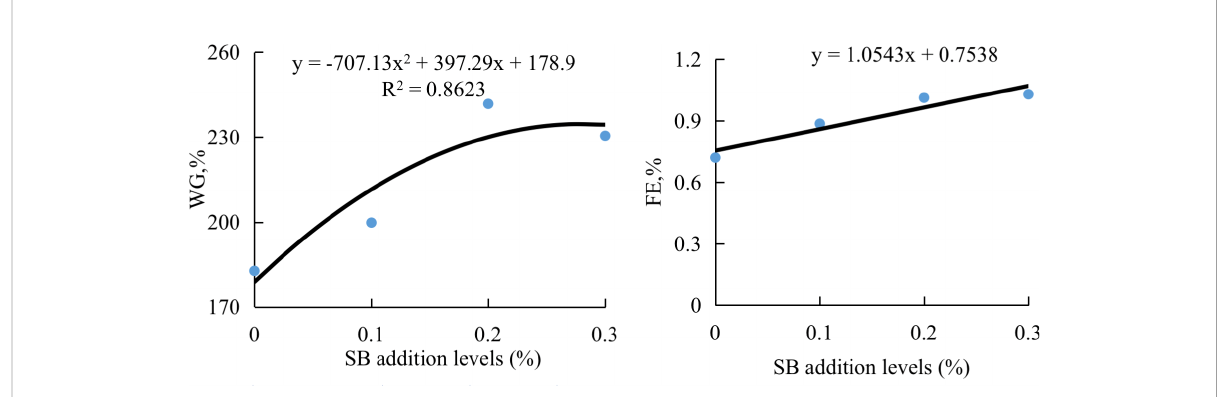
FIGURE 1 The relationship between weight gain (WG) or feed ef fi ciency (FE) of groupers and sodium butyrate (SB) inclusion levels in HSBM diets in a 56-d feeding period. Data are presented as the means of per dietary treatment (n = 3 tanks). HSBM, 60% FM protein replacement with soybean meal (SBM) in FM diet and without sodium butyrate (SB) addition; SB0.1, SB0.2 and SB0.3, 0.1%, 0.2%, and 0.3% SB were added in HSBM diets,respectively.